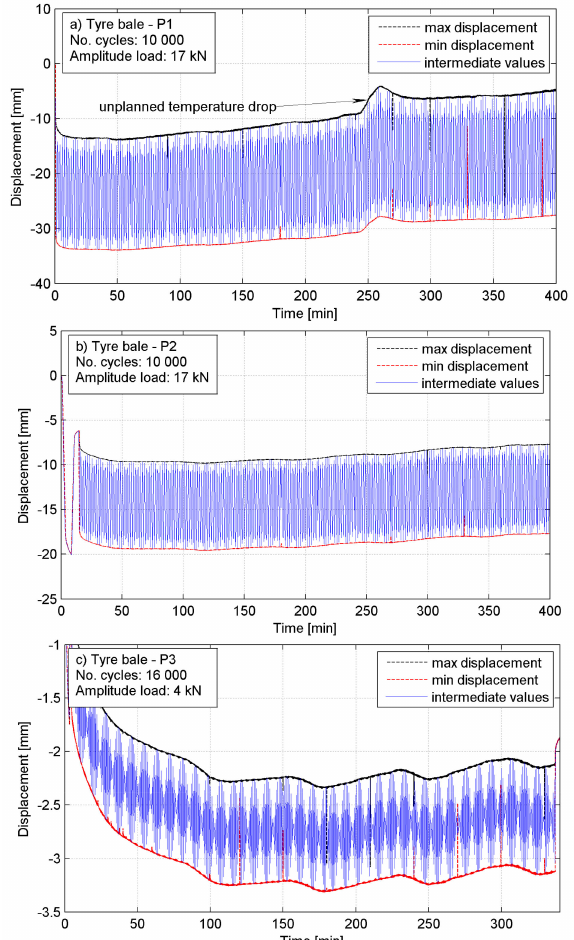
Figure 24. Time–displacements plots for subsequent testing